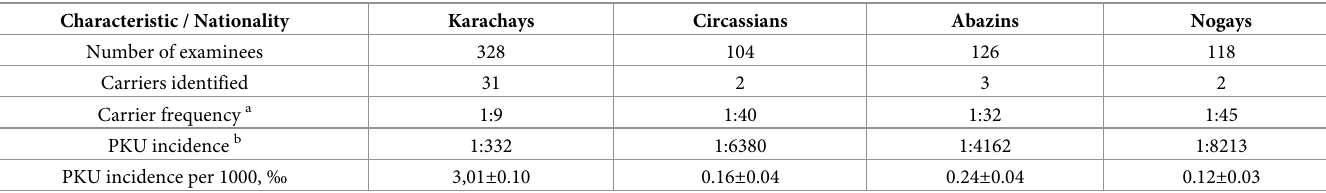
Table 1. Survey data of healthy KCR